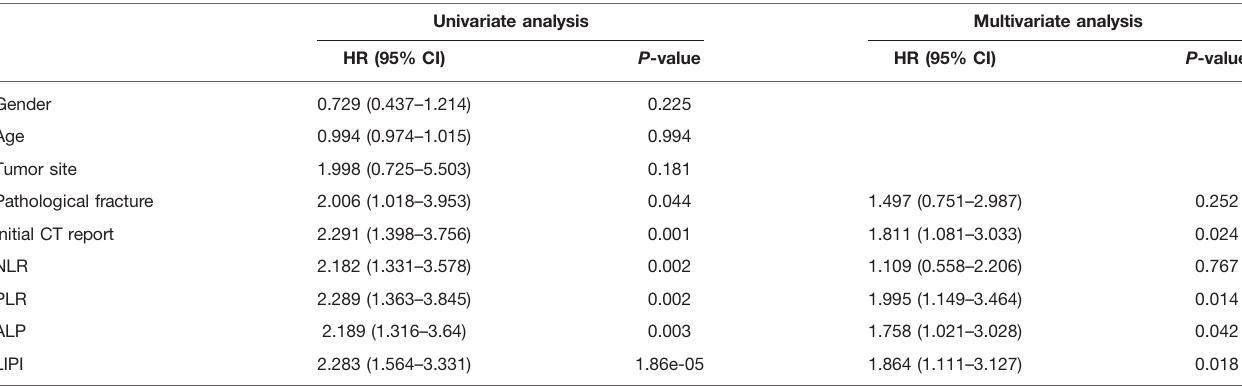
TABLE 2 | Univariate and multivariate Cox analysis for MFS.